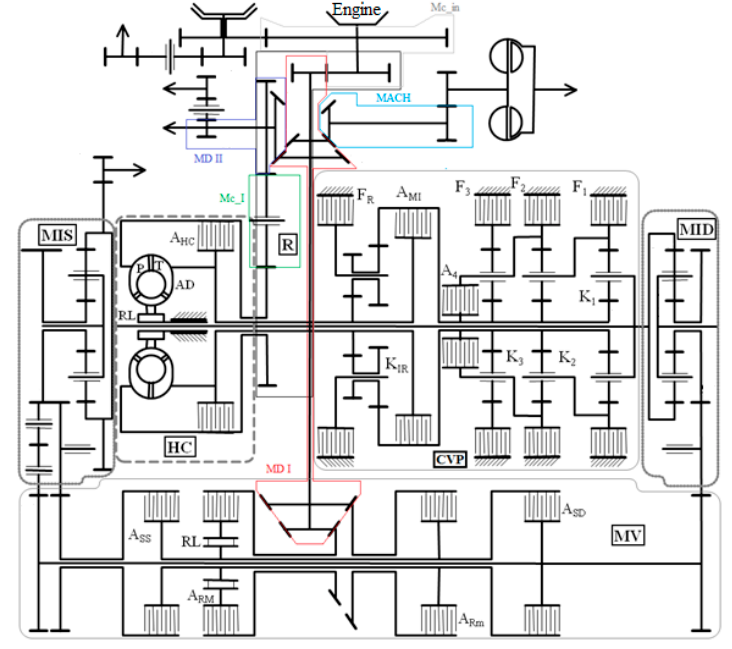
Figure 3. Kinematic diagram of the hydromechanical transmission [4].